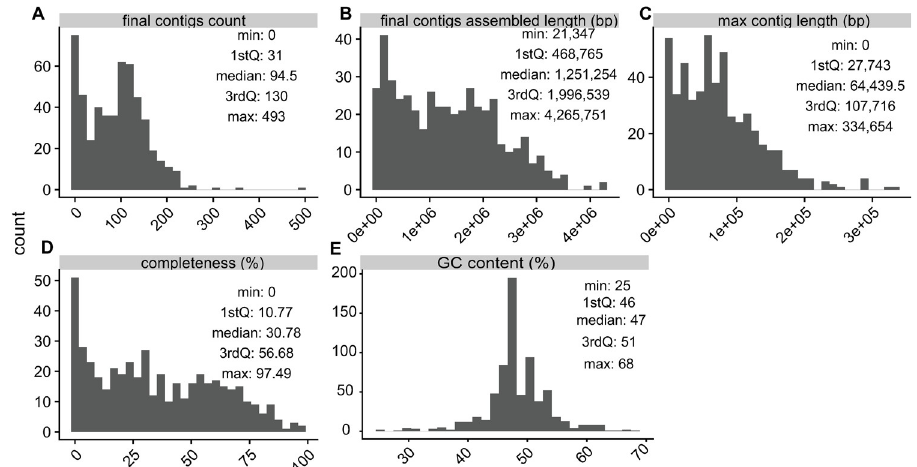
Fig 1. Quality metrics of low-coverage SAG assemblies. A faceted plot containing histograms of quality metrics used to describe the assembled SAGs. The facets display the following metrics: A) total number of contigs, B) their total assembled lengths (in number of nucleotide basepairs), C) the length of the longest contig in each assembly (in number of nucleotide basepairs), D) CheckM estimated completeness (as percentage), and E) GC content. Tukey five-number summaries (minimum, 25% quantile, median, 75% quantile, maximum) are overlaid on each metric’s panel.